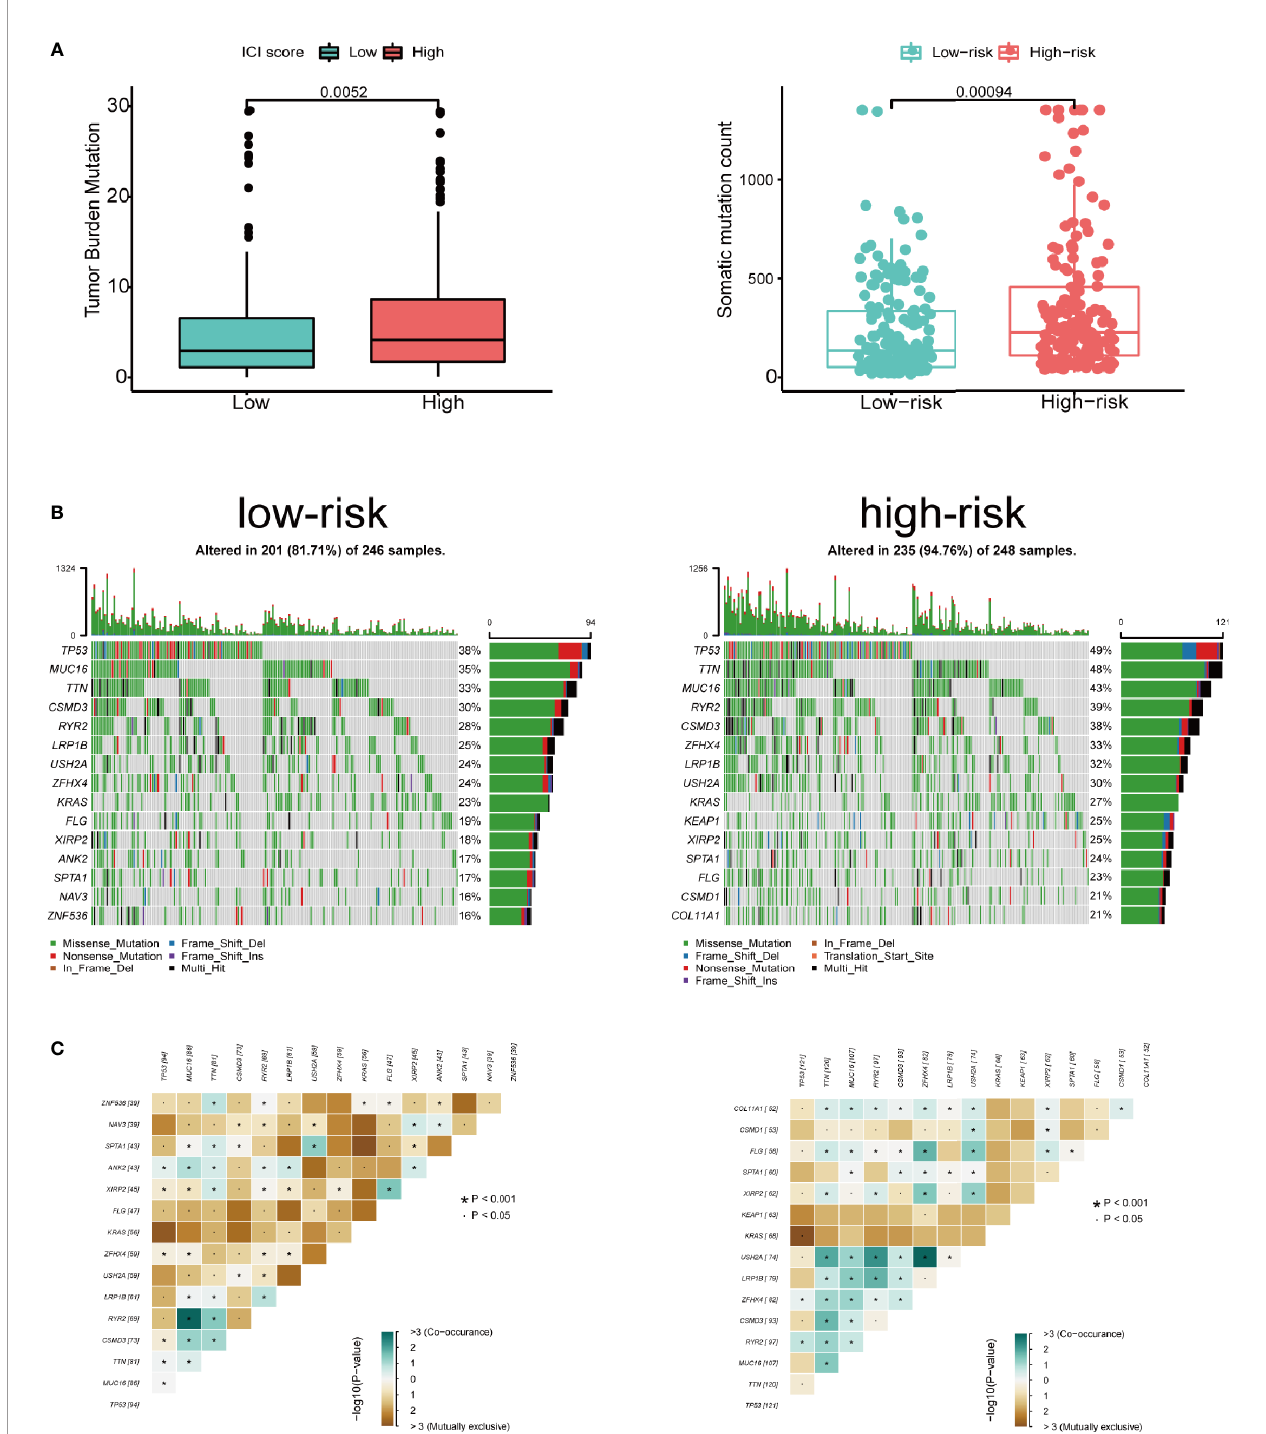
FIGURE 8 | Tumor mutation in the high- and low-risk groups. (A) Patients in high-risk group showed signi fi cantly higher tumor mutation burden and somatic mutation count. (B) TP53, MUC16, TTN, RYR2, and CSMD3 ranked the top fi ve TMB genes in both groups, and the TMB of them was drastically higher in high-risk group. (C) Correlations between mutated genes in both